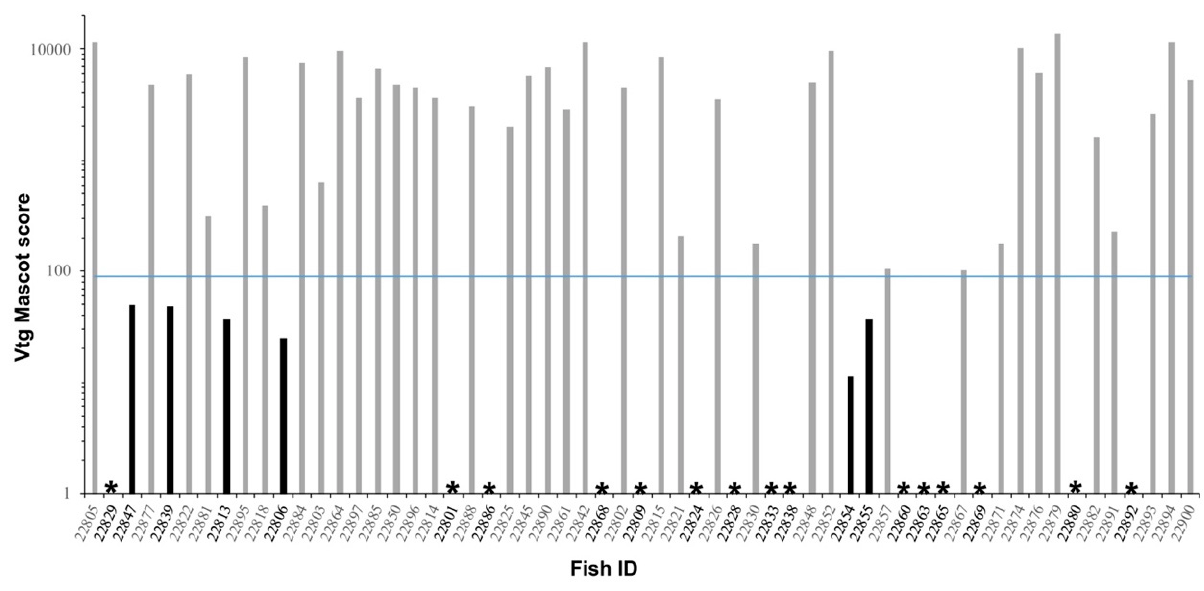
Figure 7. Vtg and Vtg cleavage products Mascot scores determined by mass spectrometry from plasma of sexually mature African bonytongue , Heterotis niloticus , (same individuals as in Figure 6). The fish with a Vtg Mascot score >90 were considered as females (gray vertical bars), those with a Vtg Mascot score ranging from 0 to 90 were considered as males (black vertical bars and * with bold IDs on the X-axis). The male/female threshold value is represented as a blue line at Mascot score = 90 (log-scale Y-axis).